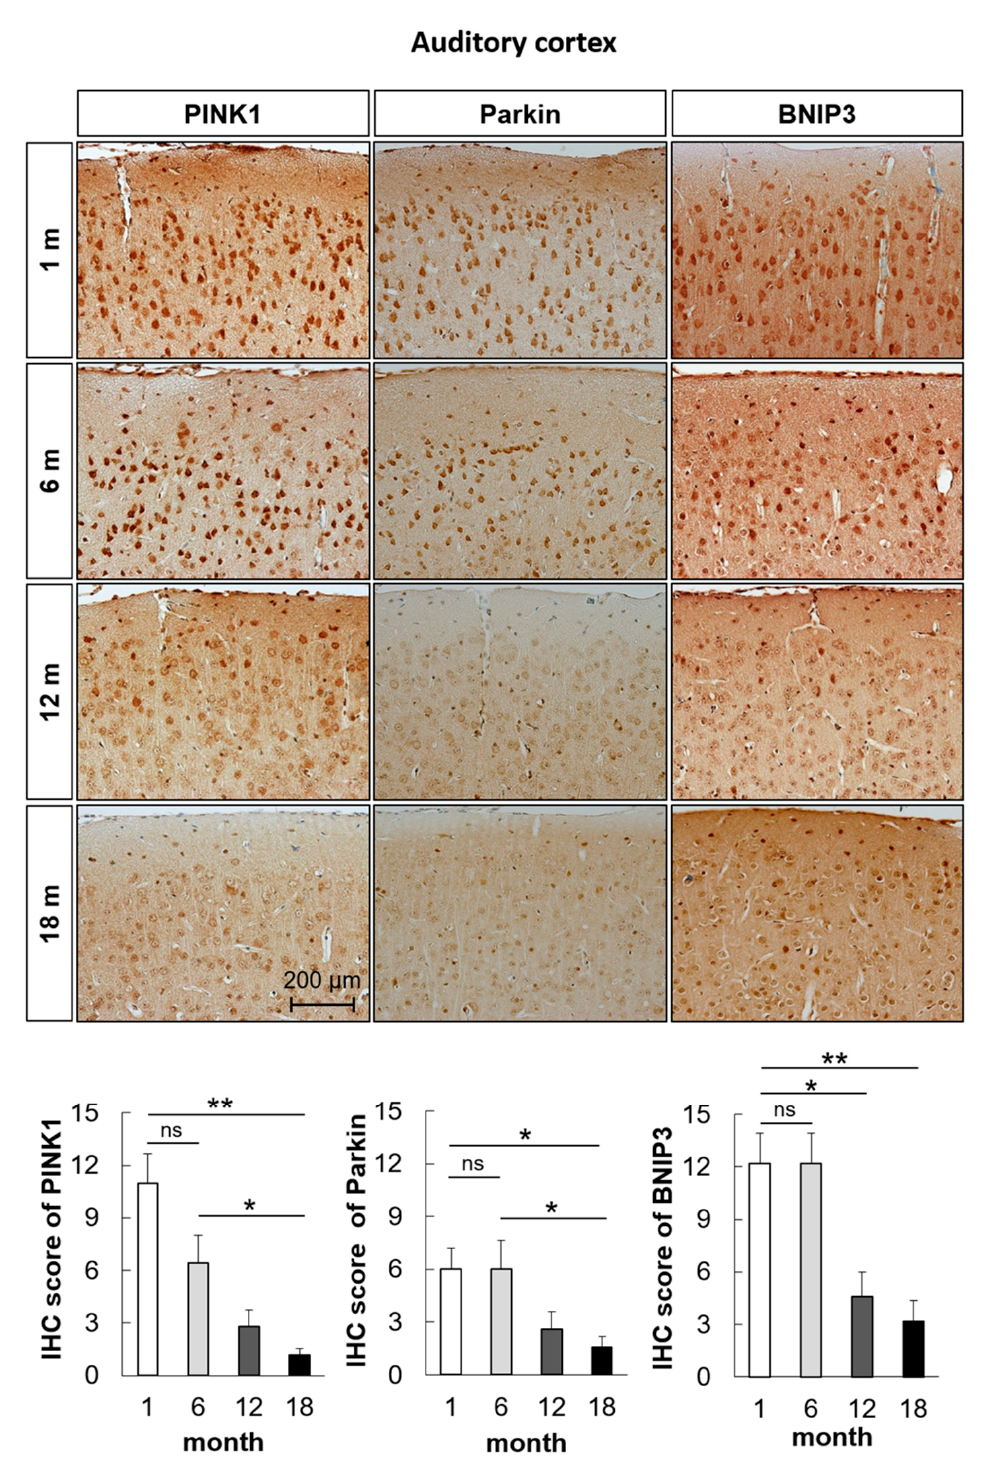
Figure 5. The protein expression levels of PINK1 , Parkin , and BNIP3 in the mouse auditory cortex decrease with aging. Immunohistochemical (IHC) scores of PINK1 , Parkin , and BNIP3 in the mouse auditory cortex significantly decreased with aging. The data are shown as mean ± standard error of mean (five mice per group; 1 m, 1 month; 6 m, 6 months; 12 m, 12 months; 18 m, 18 months). * p < 0.05, ** p < 0.01, ns: not significant.